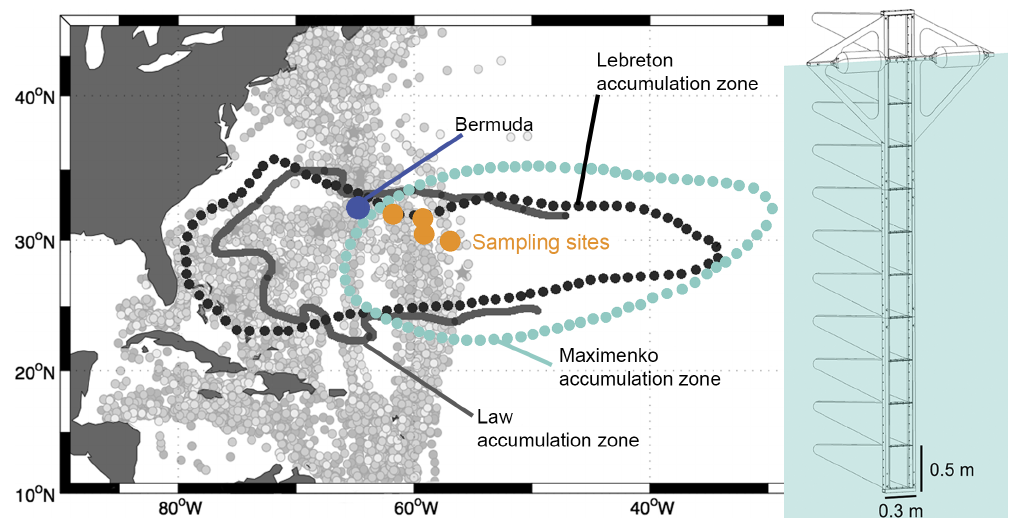
Figure 1. North Atlantic map indicating locations sampled during this study (orange dots) using the multi-level net displayed in the right panel. The four orange dots include all 12 multi-level net tows conducted in the study, which could not be shown separately due to scale. The map also shows the expedition departure and arrival location (Bermuda), as well as plastic accumulation zones predicted by ocean modelling (dotted lines) (Lebreton et al., 2012; Maximenko et al., 2012), and a surface net tow data set (solid gray line; grey dots show locations of net tows) (Law et al.,